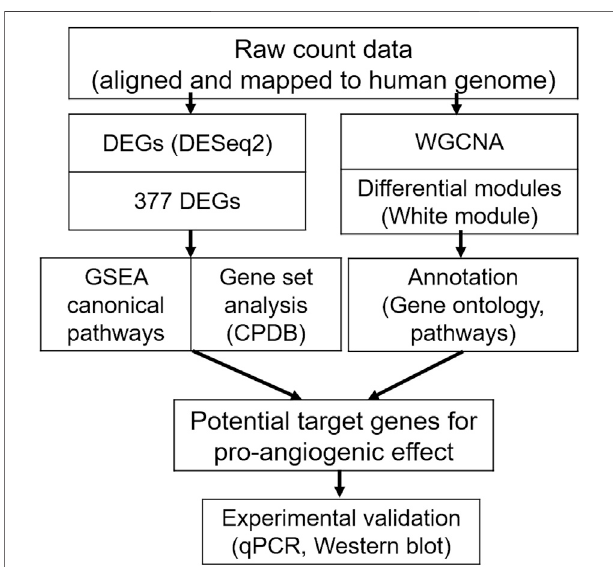
FIGURE5| Work fl owoftheRNA-sequencing(RNA-Seq)analysisforthe ginsenoside Rb2/Rg3 combination, compared to the control group. Firstly (left) ,differentially expressed genesweredeterminedusingDESeq2.The377 differentially expressed genes in the combination-treated group were subject to Gene Set Enrichment Analysis (GSEA) and Consensus Path DB (CPDB) gene set analyses. In parallel (right) , Weighted Gene Co-expression Network Analysis (WGCNA) was performed on combination treated vs untreated cells, and the resulting white gene module was subject to Gene Ontology and pathway analysis. Both methods together were used to understandthesynergisticeffectoftheginsenosidecombinationtreatmenton a mechanistic level, and formed the basis of selecting 18 genes for further experimental validation by qPCR and Western